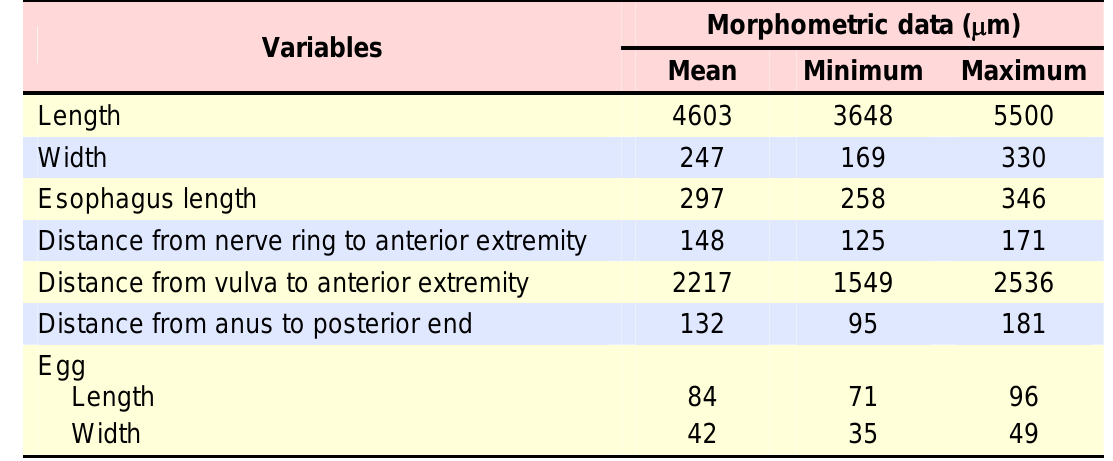
Table 1. Morphometric data of partenogenetic female of Rhabdias sp. from Crotalus durissus terrificus lung in